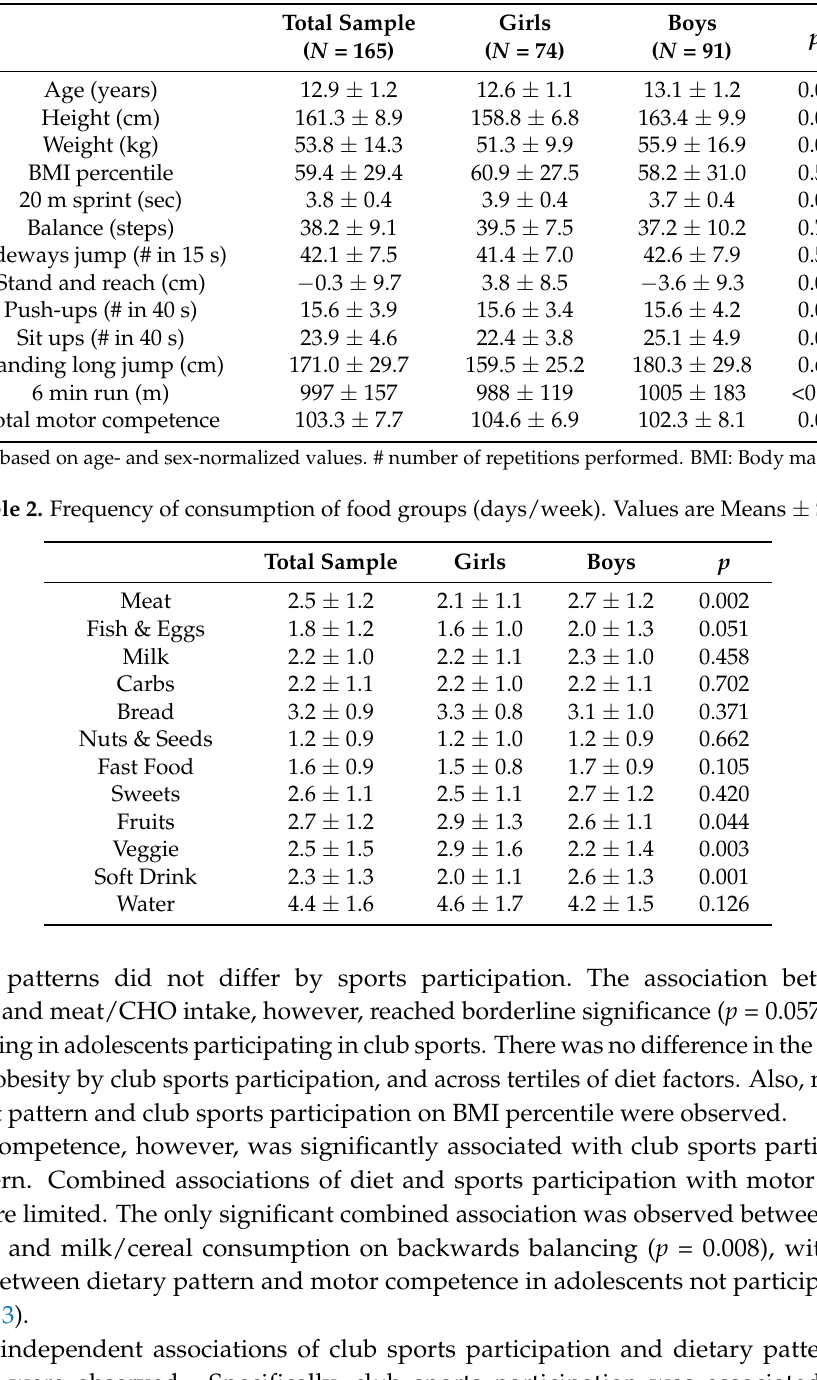
Table 1. Anthropometric characteristics and motor competence for the total sample and separately for girls and boys. Values are mean ± SD.